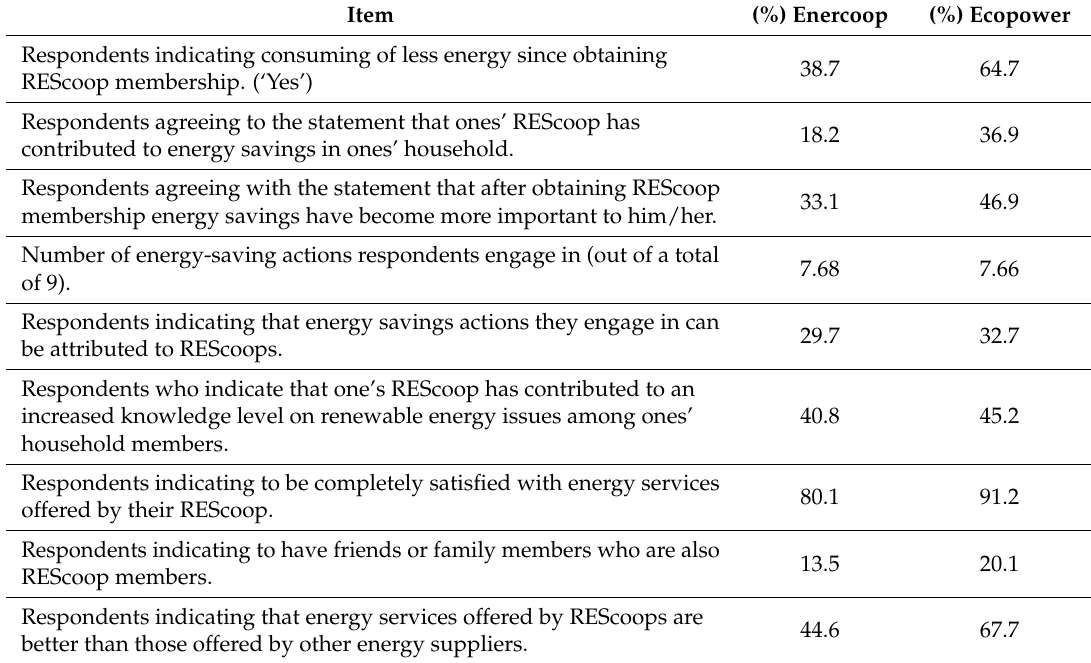
Table 4. Relative frequencies of cooperatives and energy conservation for Enercoop and Ecopower. Item (%) Enercoop (%) Ecopower